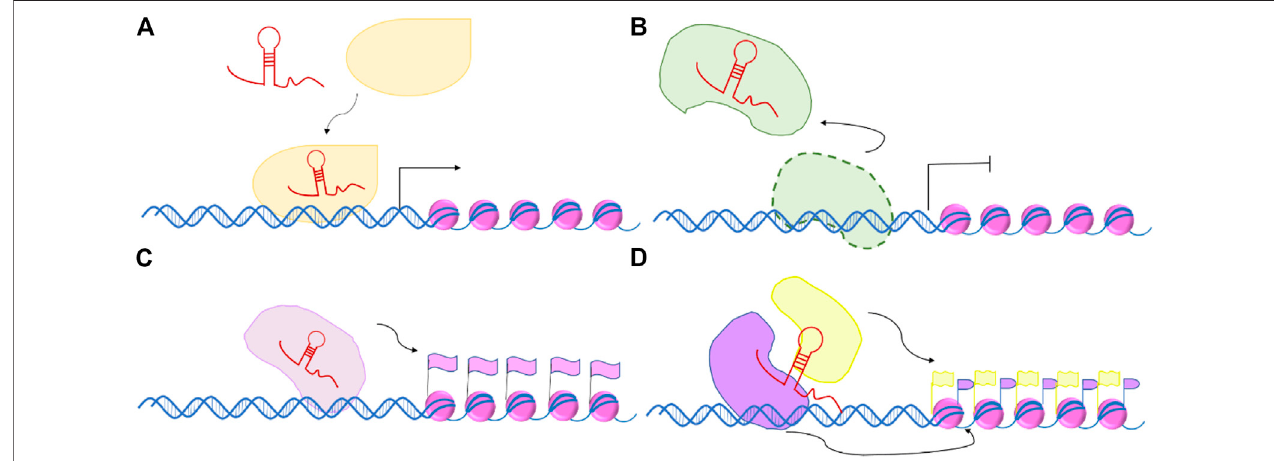
FIGURE 2 | Modes of action long non-coding RNAs. (A) Signal, (B) Decoy, (C) Guide, and (D) Scaffold.